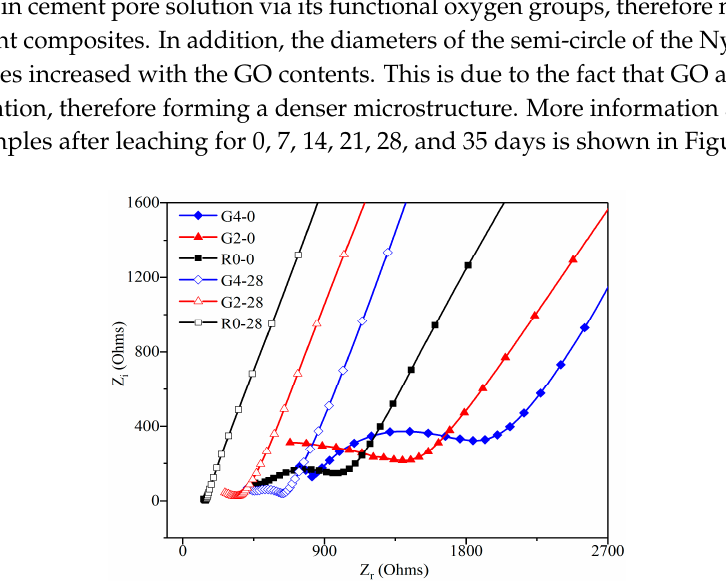
Table 5. Fitting results of R CCP based on the modified model (Q mat (Q DP R CP ) R CCP ) (Q L R L ) for the leached samples at different leaching durations